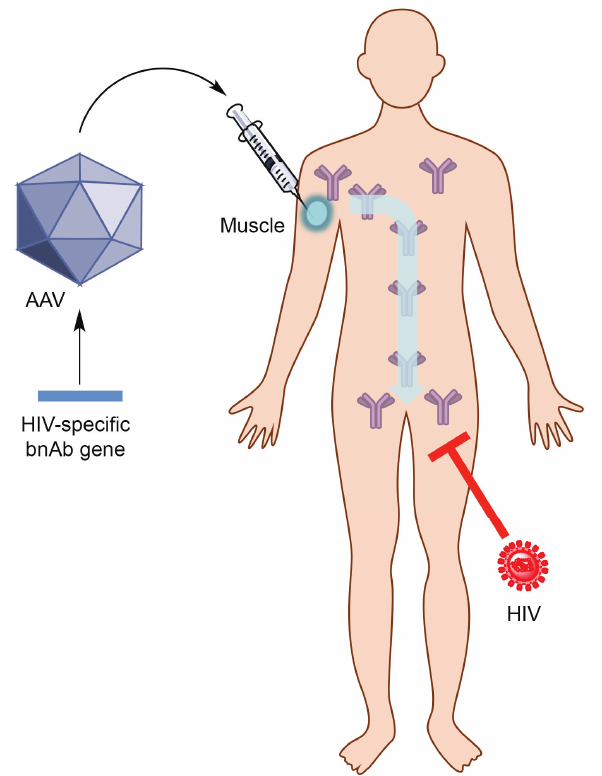
Figure 1. Schematic representation of the Adeno-associated virus-based vector (AAV)- based Vectored ImmunoProphylaxis (VIP) approach against human immunodeficiency virus